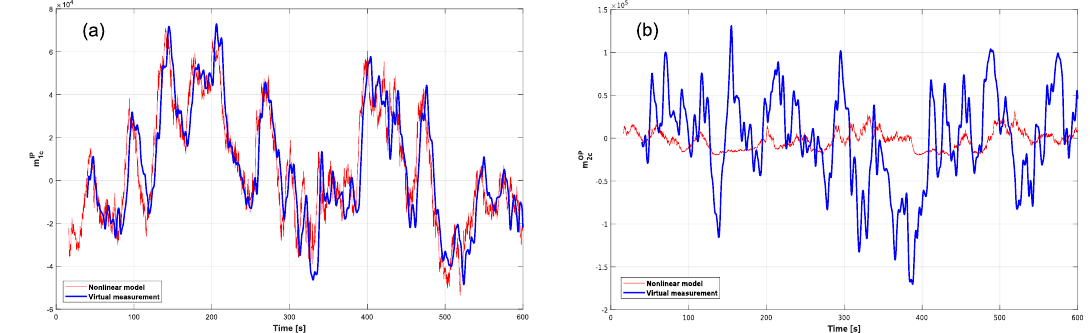
Figure 5. Comparison in turbulent wind conditions between measured harmonics (thick solid line) and harmonics predicted with a second- order nonlinear model (thin solid line). (a) In-plane 1